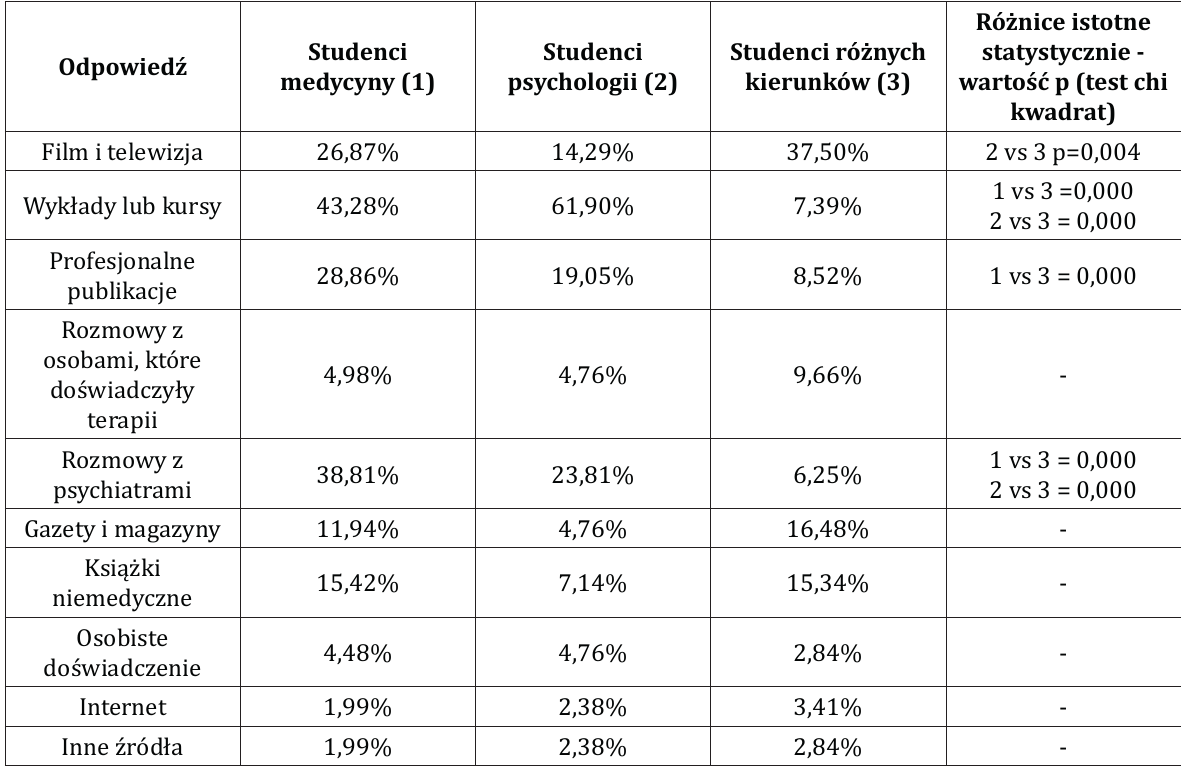
Tabela 2. Dane na temat źródeł wiedzy wśród studentów